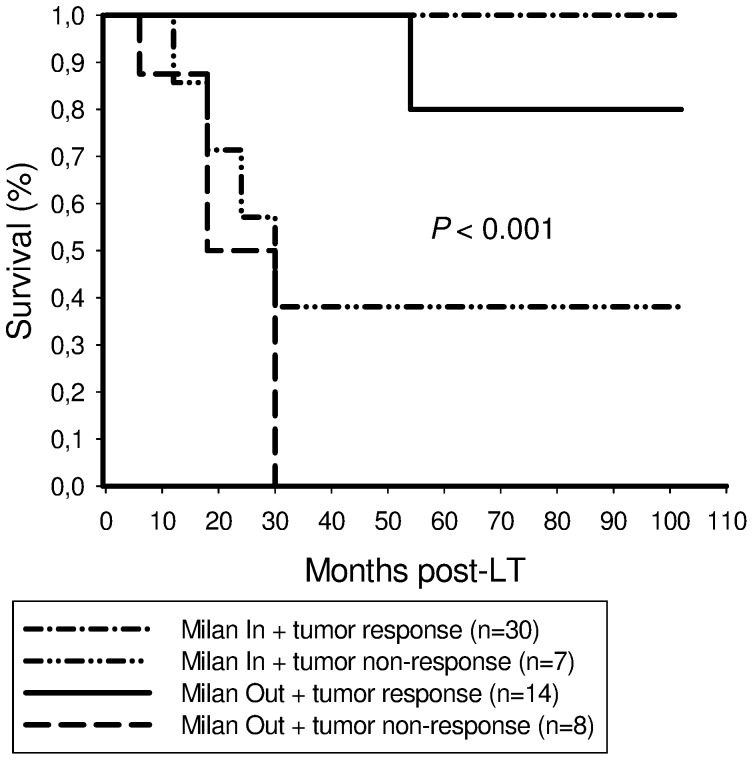
This graph illustrates outcome stratified by Milan criteria and post-IBT tumor response.We found excellent 5-year recurrence-free survival in Milan In and Milan Out patients with postinterventional tumor response (100%/80%), compared to inferior outcome in Milan In and Milan Out recipients without extended post-IBT tumor necrosis (38,1%/0%; P<0.001), respectively.